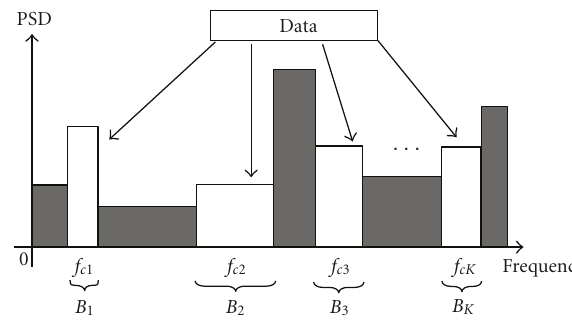
Figure 1: Illustration of dispersed spectrum utilization in cognitive radio systems. White and gray bands represent available and unavailable bands after spectrum sensing,